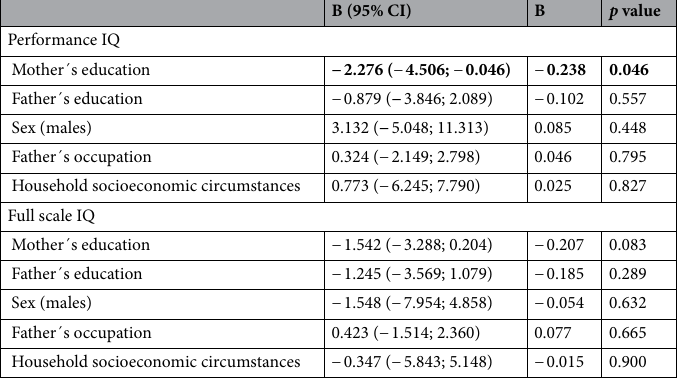
Table 2. Associations of parental education with cognitive ability at age 28/29. IQ = intelligence quotient; B = unstandardized coefficient from linear regression; β = standardized coefficient from linear regression; CI = confidence interval. All variables are included in the models. Significant values are in [bold].